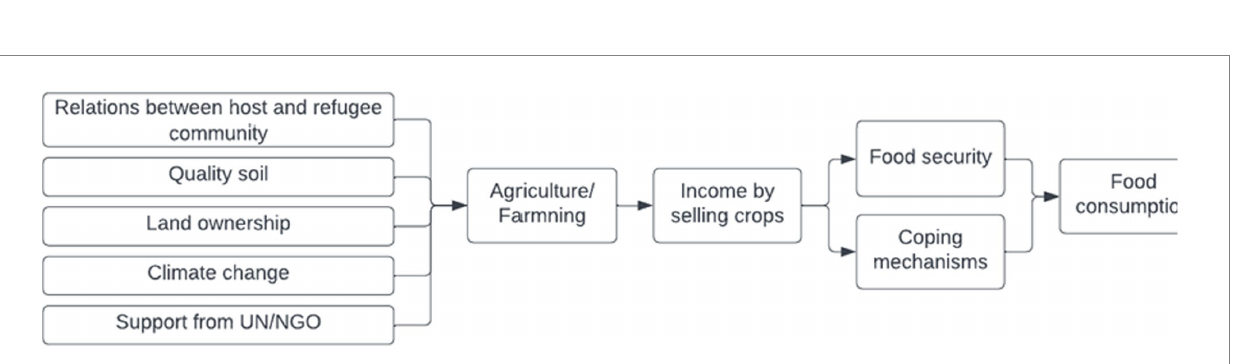
FIGURE 2 Conceptual framework of food system in South Sudan Refugee and Uganda host community, Northern Uganda*. *Author’s Own